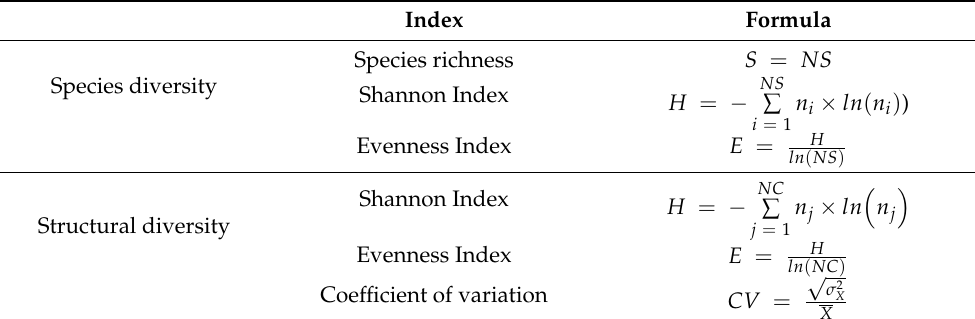
Structural diversity